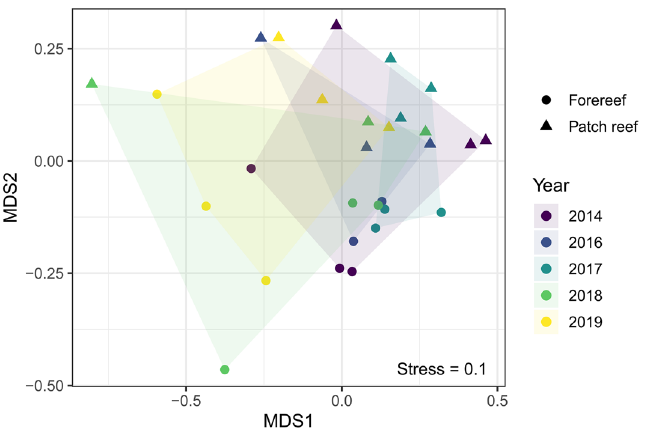
Figure 4. Spatial and temporal variation in benthic community composition visualized using non-metric multidimensional scaling. Points correspond to each locality in each year, and shaded areas are convex